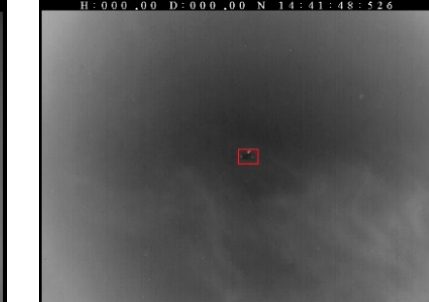
( b ) ( c ) ( d ) Figure 2. Some infrared images in our infrared small-target OEDD. ( a ) Large and medium aircraft; ( b ) small aircraft; ( c ) floating ball; ( d ) birds. 2.2. Data Preprocessing For the private multi-source infrared small-target dataset, data preprocessing in- cludes Two parts: (1) Original data augmentation and (2) original image denoise.